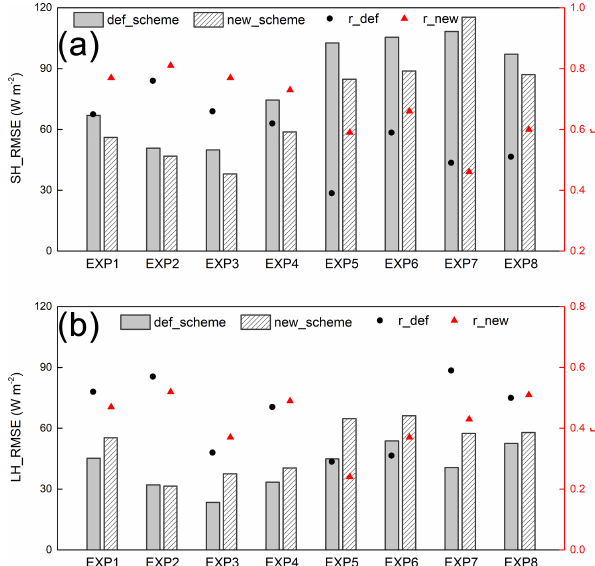
Figure 8. Same as Fig. 5 but for sensible (a) and latent (b) heat fluxes. The correlation coefficient is significant at the 0.001 signifi- cance